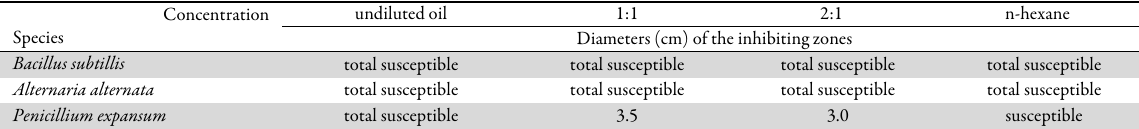
Table 2. The diameters of the inhibition areas determined by the undiluted and diluted basil oil for the studied species Concentration